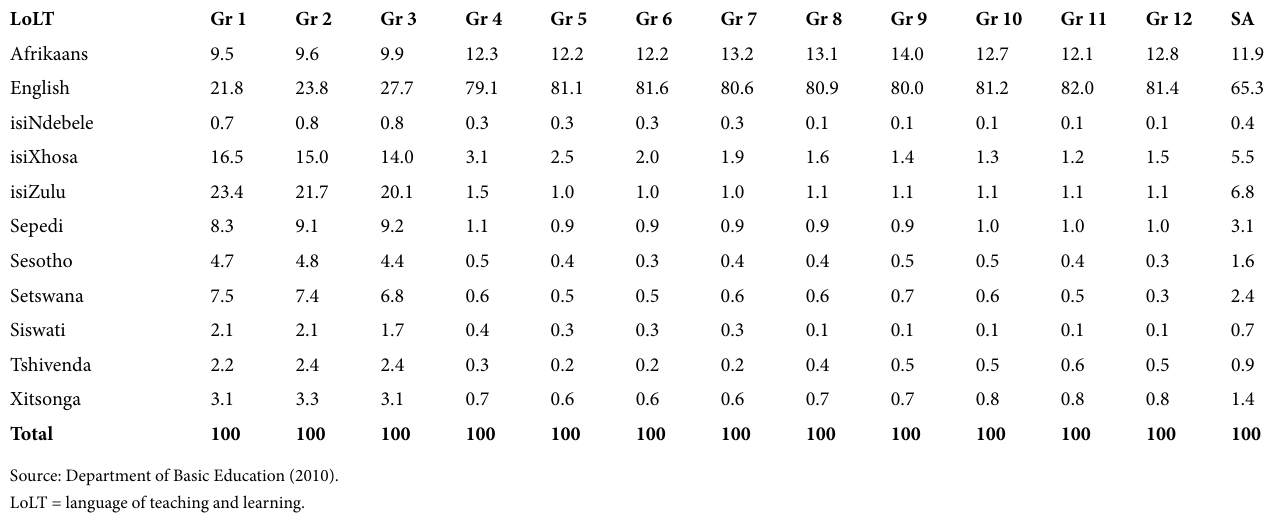
Table I. Percentage of learners by language of learning and teaching across grades in 2007 LoLT